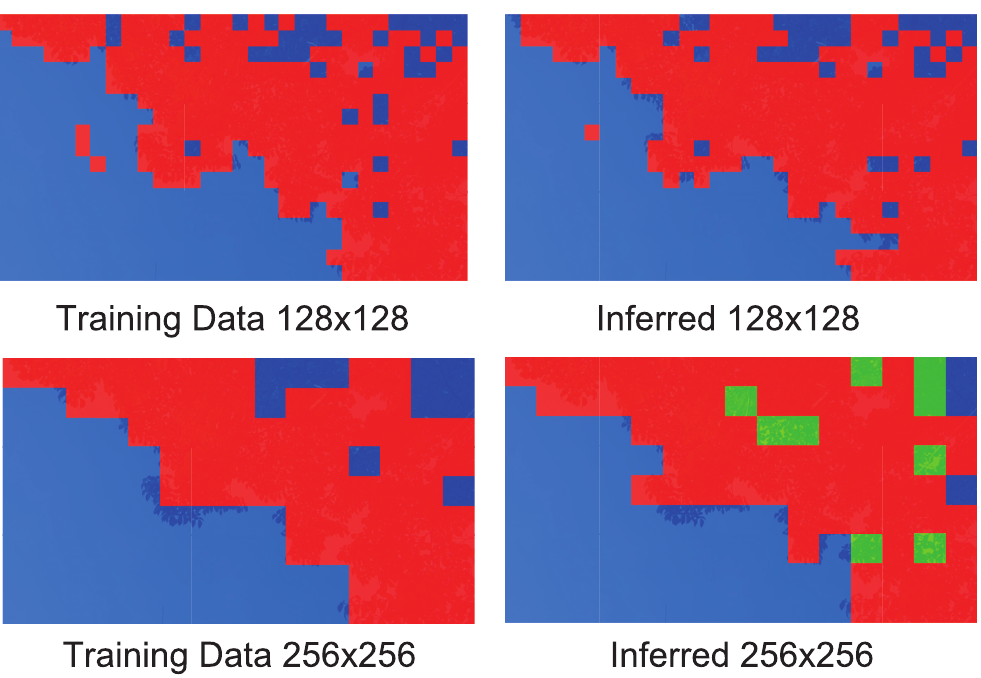
Figure 8. Comparisons among distributions of compression programs used for training and inferred by DNN